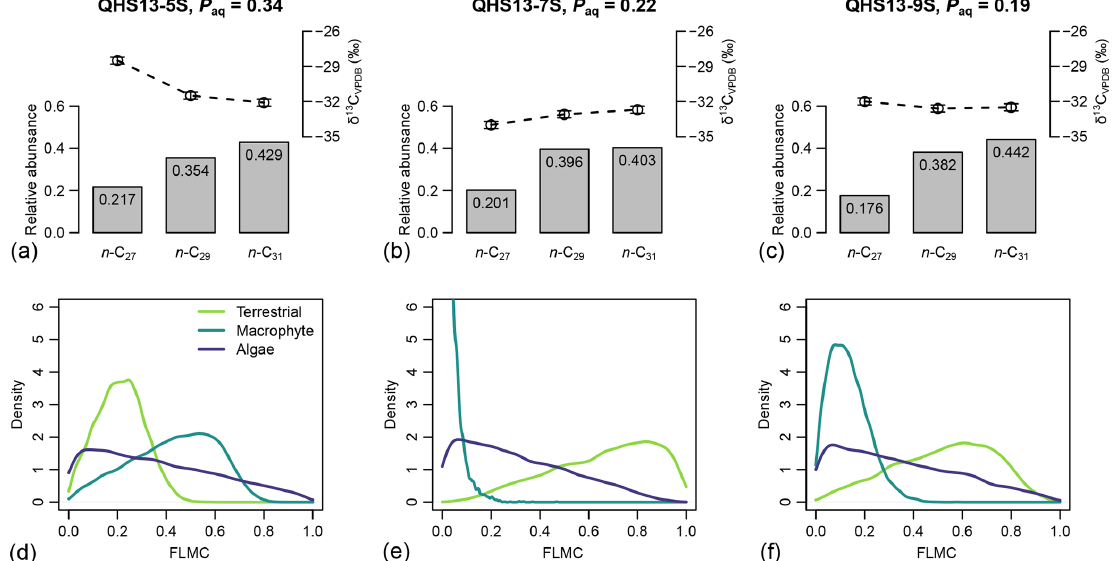
Figure 5. (a–c) Sedimentary long-chain n -alkanes ( n -C 27 , n -C 29 , and n -C 31 ), their δ 13 C (‰, VPDB) and relative abundance values (ex- cluding other chains) in published lake surface sediment samples from Lake Qinghai (Liu et al., 2015). (d–f) Posterior densities of fractional leaf mass contribution (FLMC) of terrestrial plants, aquatic macrophytes, and algae as model output conditioned on the δ 13 C and relative abundance